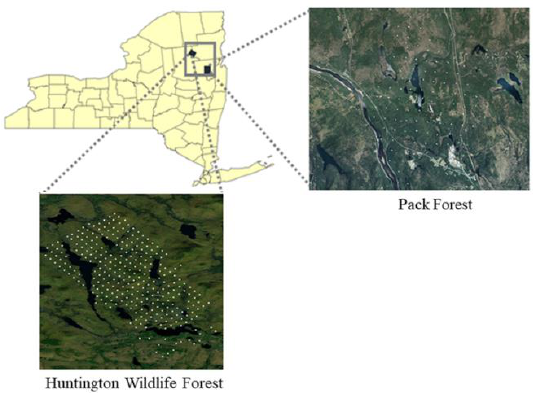
Figure 1 . Location of the study area (Essex and Warren, NY). White circles indicate sample plots located in Huntington Wildlife Forest (HWF) and Pack Demonstration Forest